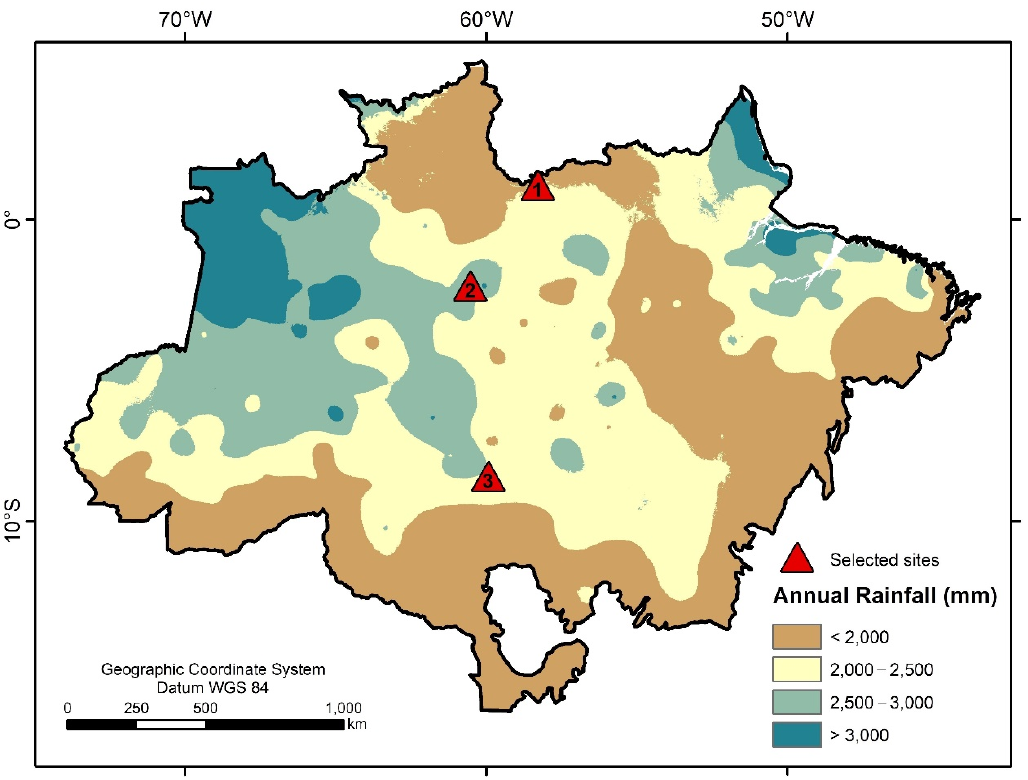
Figure 1. Location of the three studied sites in the Brazilian Amazon (site 1 = Grão Pará; site 2 = Manaus; and site 3 = Aripuanã). Average annual rainfall data (1960–1990) were interpolated from available weather stations at a 1 km spatial resolution (WorldClim database), as described by Hijmans et al. [24].